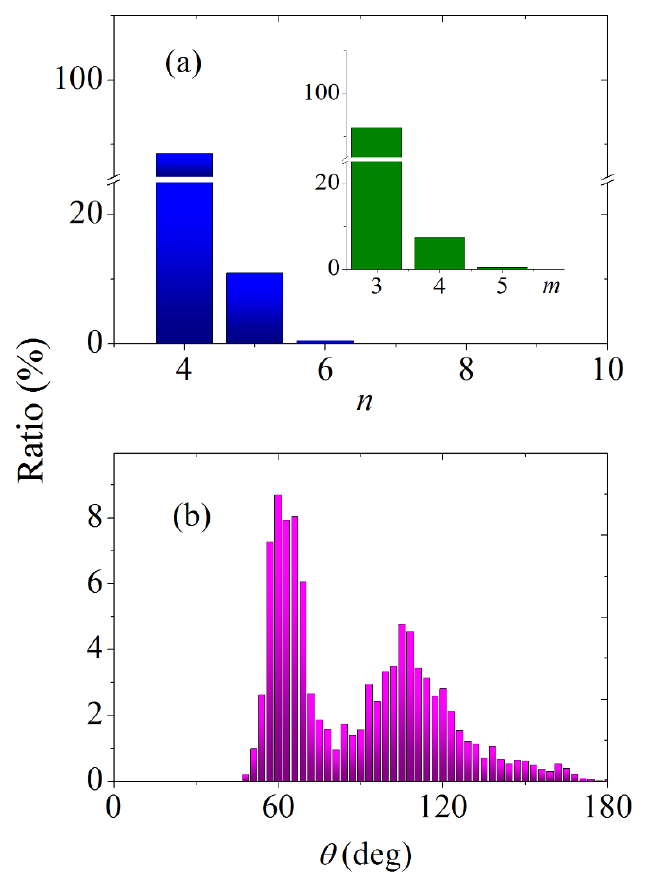
Figure 13. Distributions for Ce subsystem of molten salt mixture FLiNaK+CeF 3 at a temperature of 950 K in form of: ( a ) VP by number of faces and VP faces by number of sides (in the insert), ( b ) angles θ .